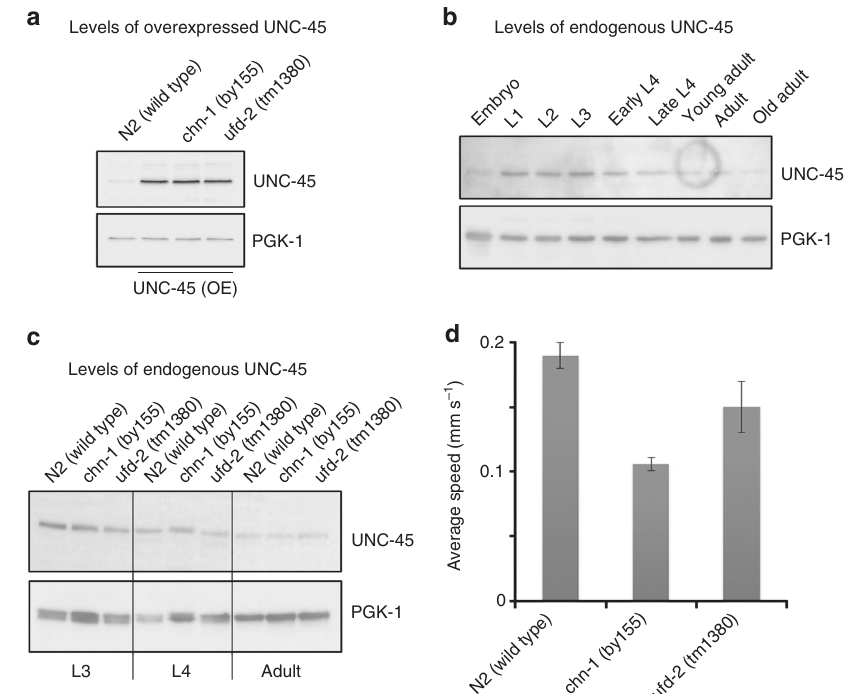
Fig. 2 Functional interaction between UNC-45, CHN-1, and UFD-2 in vivo. a Comparison of UNC-45 protein levels when overexpressed in unc-45(OE) , ufd- 2(tm1380), and chn-1(by155) adult worms. PGK-1 was used as a loading control. b Western blot analysis showing the protein levels of endogenous UNC-45 at different stages of C. elegans development. c Western blot analysis showing protein levels of endogenous UNC-45 in wild-type, ufd-2(tm1380), and chn-1 (by155) worms at the L3, L4, and adult developmental stages, respectively. d Average speed (mm s − 1 ) of indicated worms as determined in motility assays. Error bars represent sample standard deviation. Uncropped images of all western blots are shown in Supplementary Fig.